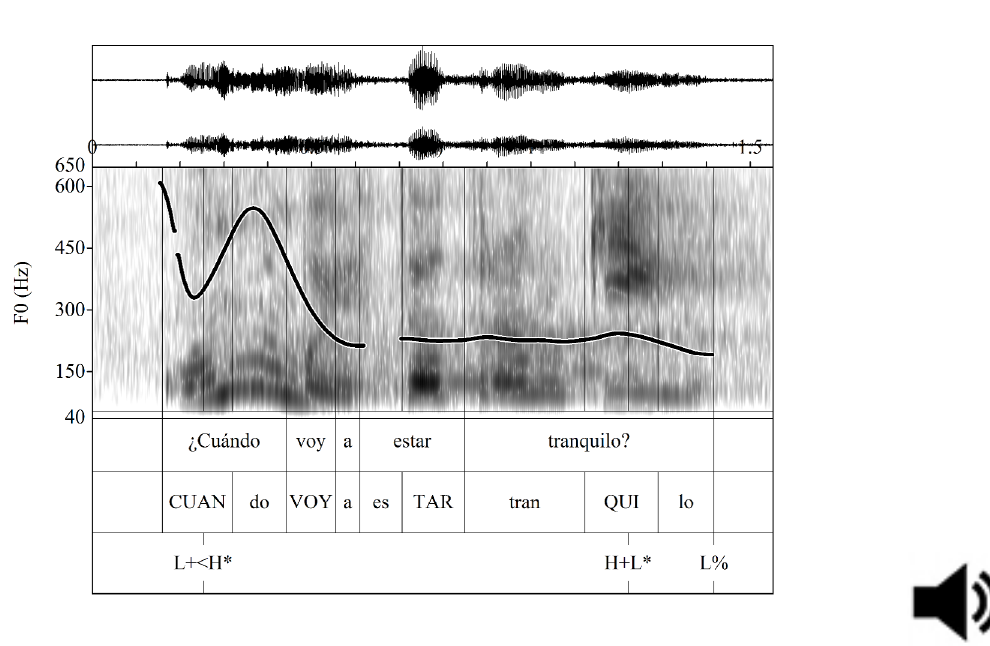
Figure 23 (Participant 12): Waveform and F0 trace for the rhetorical wh- question ¿Cuándo voy a estar tranquilo? ‘When am I going to be left alone?’ produced as L+<H* (1 st prenuclear position), deaccenting (2 nd and 3 rd prenuclear positions) and as H+L* L% (nuclear